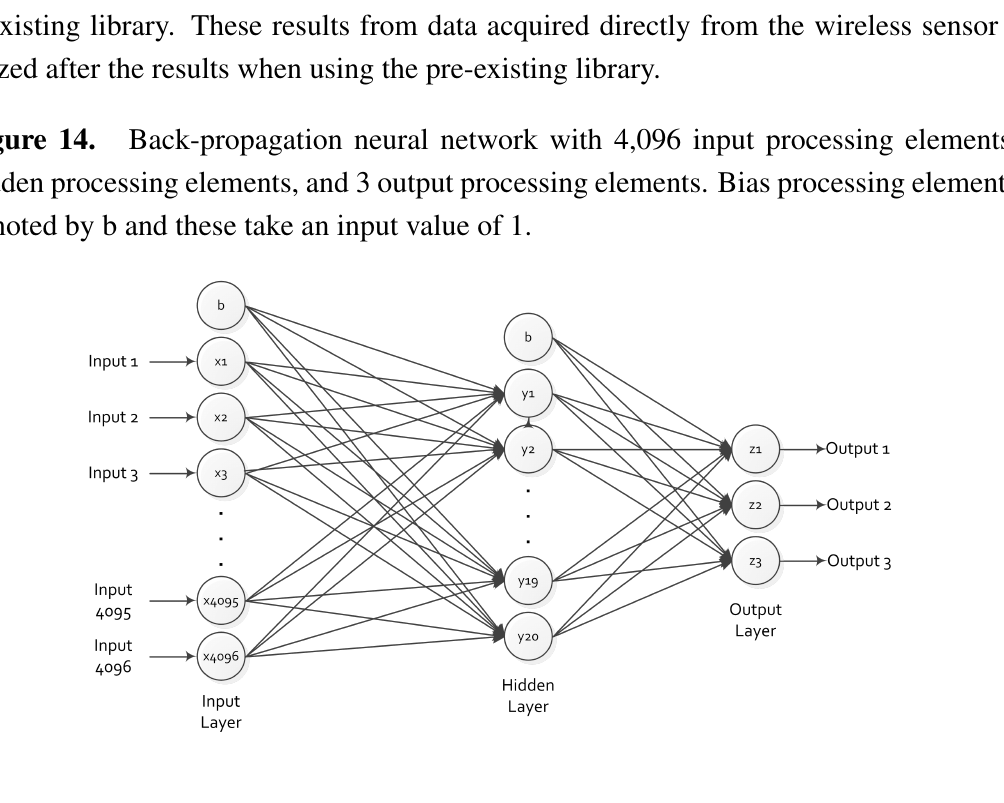
Table 1. Number of samples per class used in the neural network training and testing